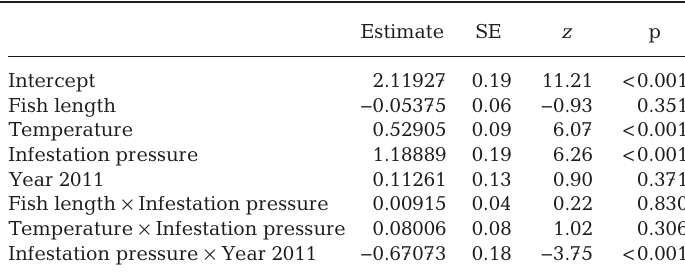
Table 2. Summary from the zero-truncated negative binomial generalized linear mixed model predicting numbers of attached lice on infested wild salmonids. For further information on variables see Table 1